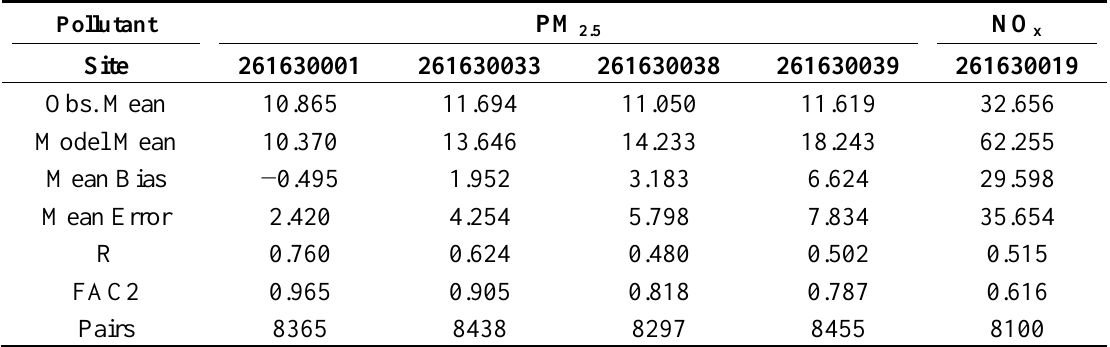
Table 1. Statistics metrics for the model-to-monitor comparison at the five AQS monitoring stations for PM and NO . 2.5 x